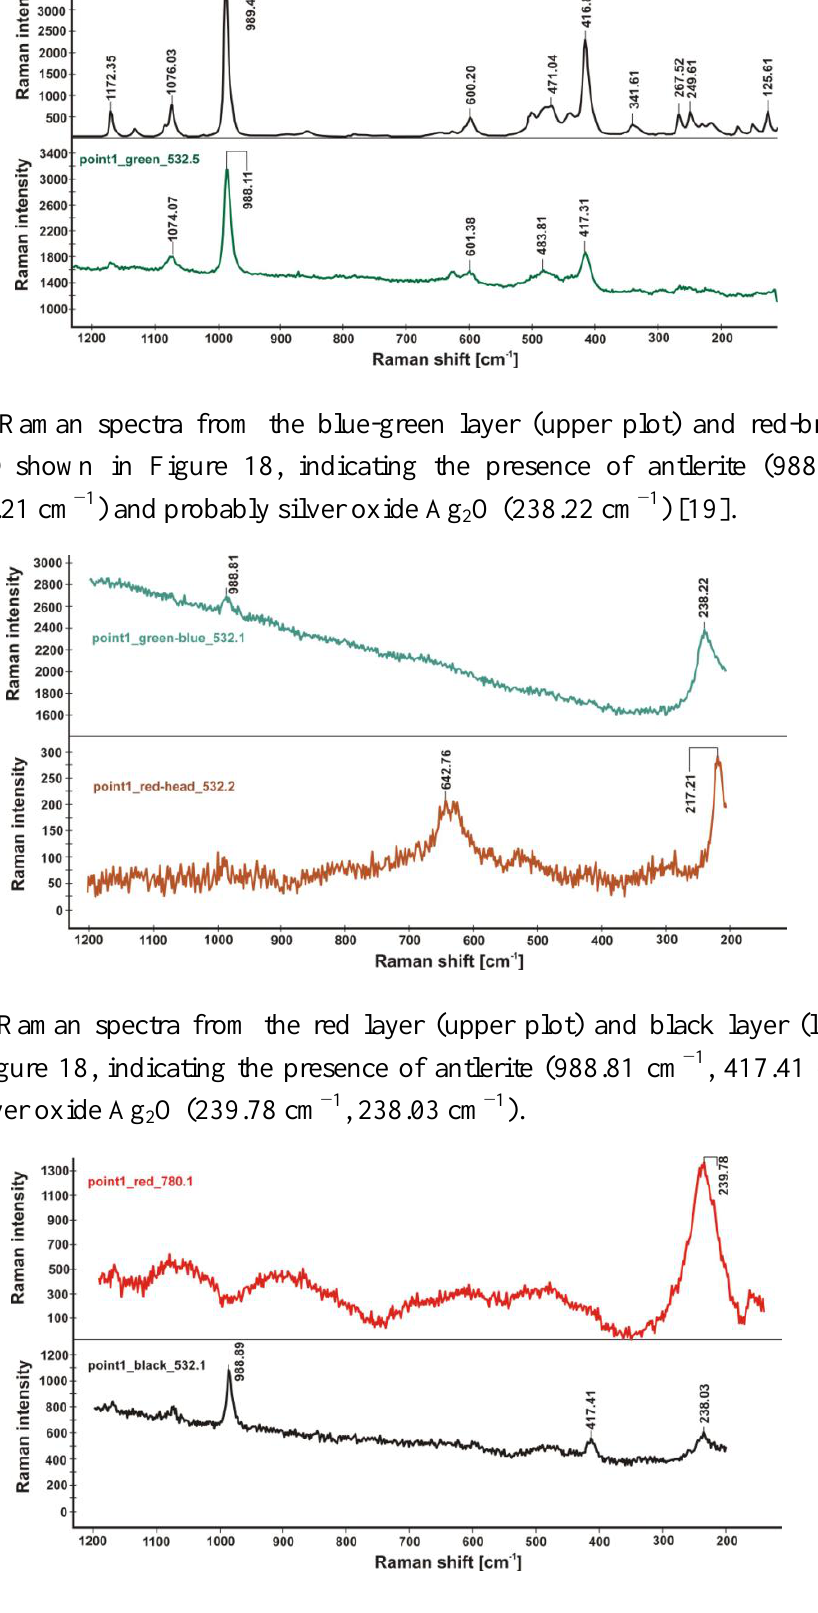
SO (OH) (upper plot) with 3 4 4